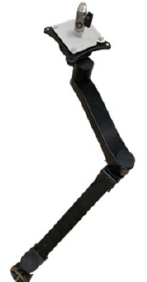
Figure 14. Universal arm.